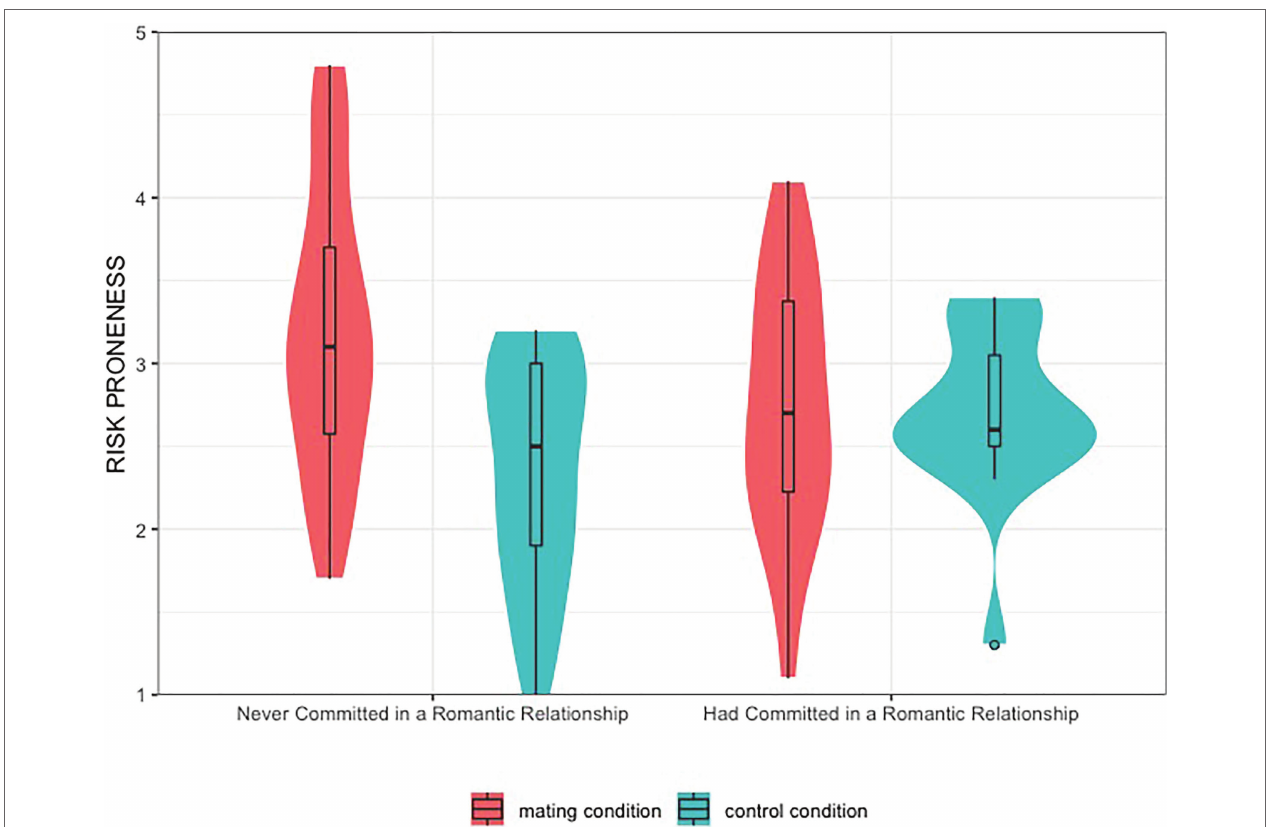
FIGURE 1 | Men’s financial risk-taking tendency as a function of condition and relationship experience in Experiment